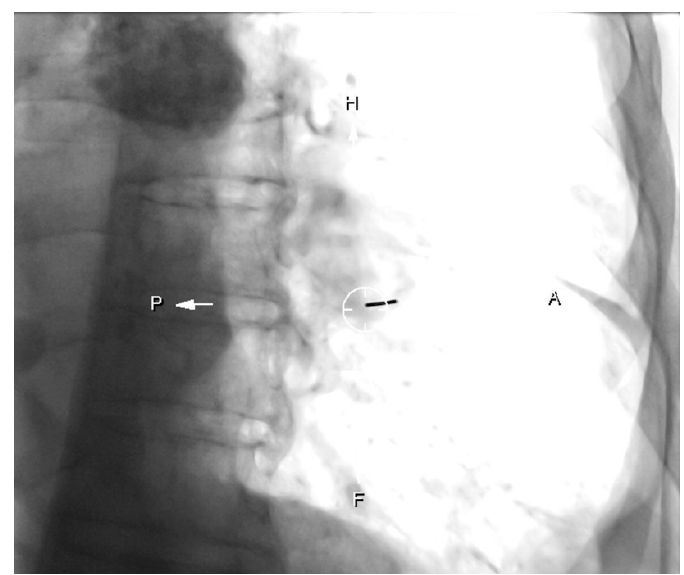
Figure 1. Patient with left low lobe mass. “Bulls-eye” projection: the coaxial needle is entering in the point of the skin indicated and aligned with the target point (circle).